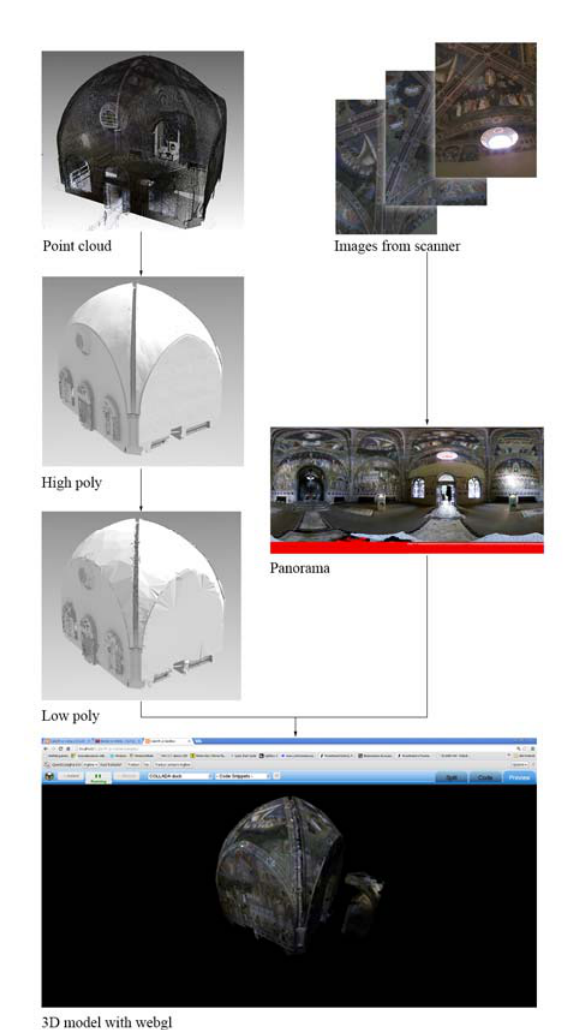
Figure 5. Schema to trasform point cloud in webgl